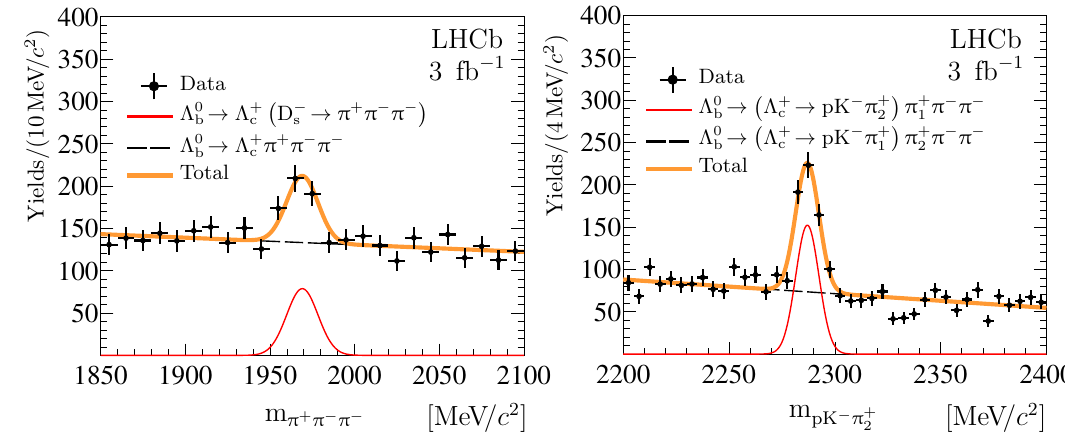
Figure 4 . Background-subtracted (left) π + π − π − mass distribution from Λ 0 and (right) pK − π + the fits described in text are